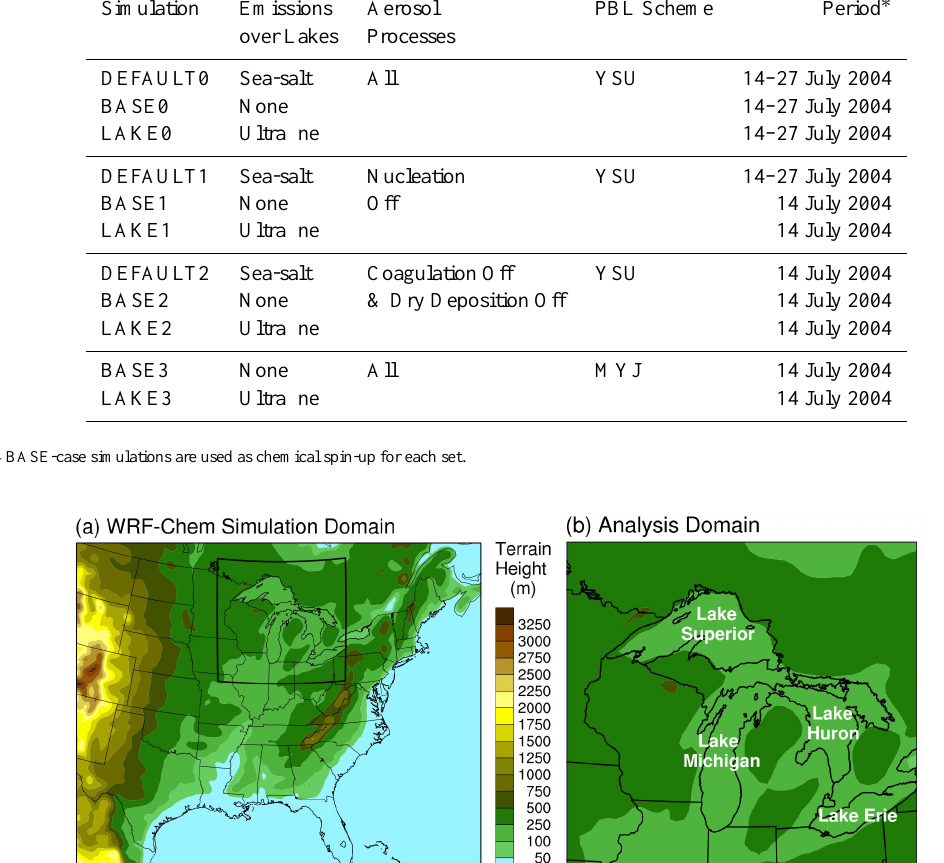
The DEFAULT, BASE, and LAKE cases were